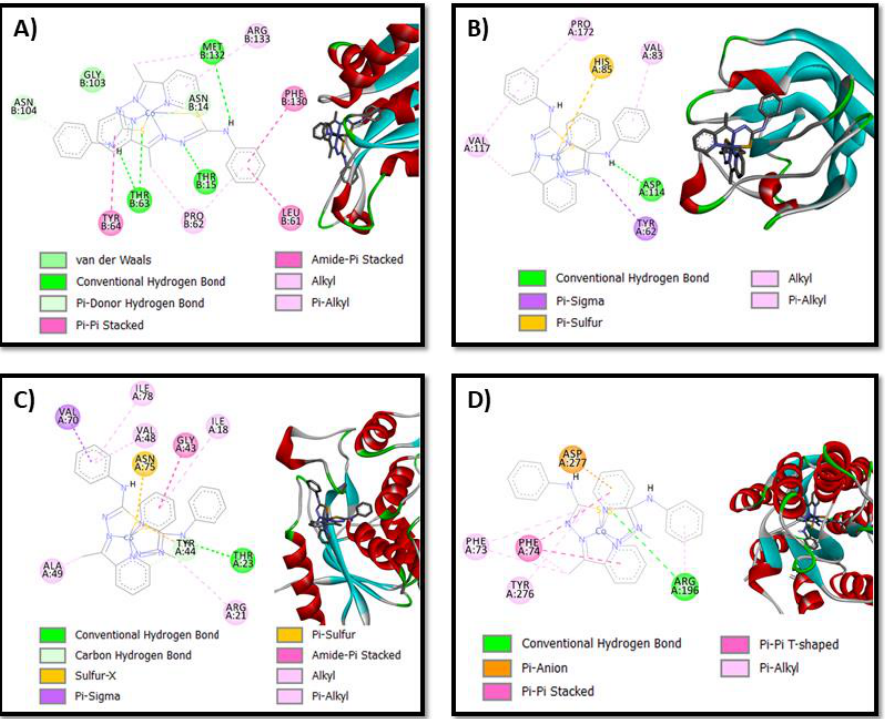
Figure 5. Interaction network between the [Co ( atc-Ph) 2 ] + complex and ( A ) S. mutans ; ( B ) S. mitis ; ( C ) S. sanguinis ; and ( D ) L. paracasei protein structures. For clarity, the non-polar hydrogen atoms of the metal complex are omitted.